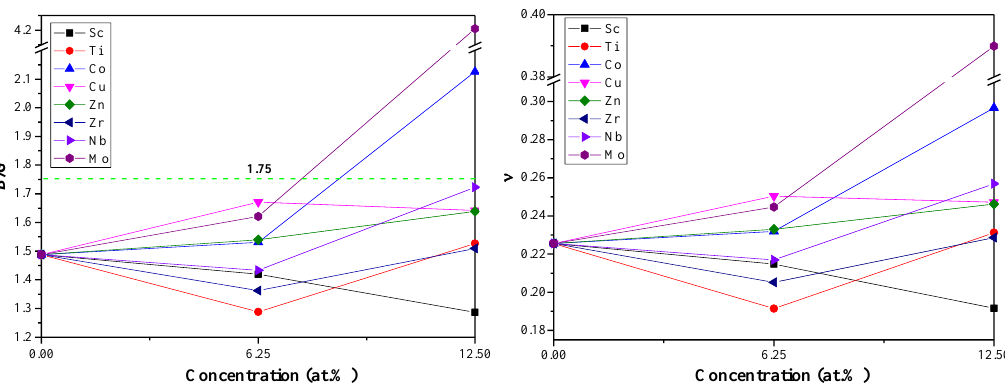
Figure 3. Simulated B / G and ν of Al 3 Li doped with alloying element X (X = Sc, Ti, Co, Cu, Zn, Zr, Nb, and Mo) as a function of doping concentration.